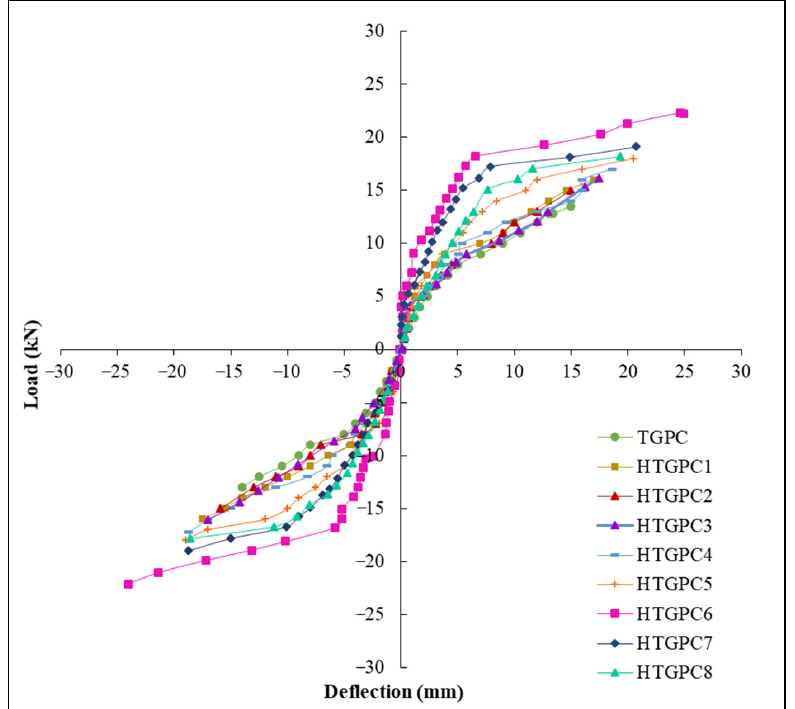
Figure 6. Envelope of load-deflection